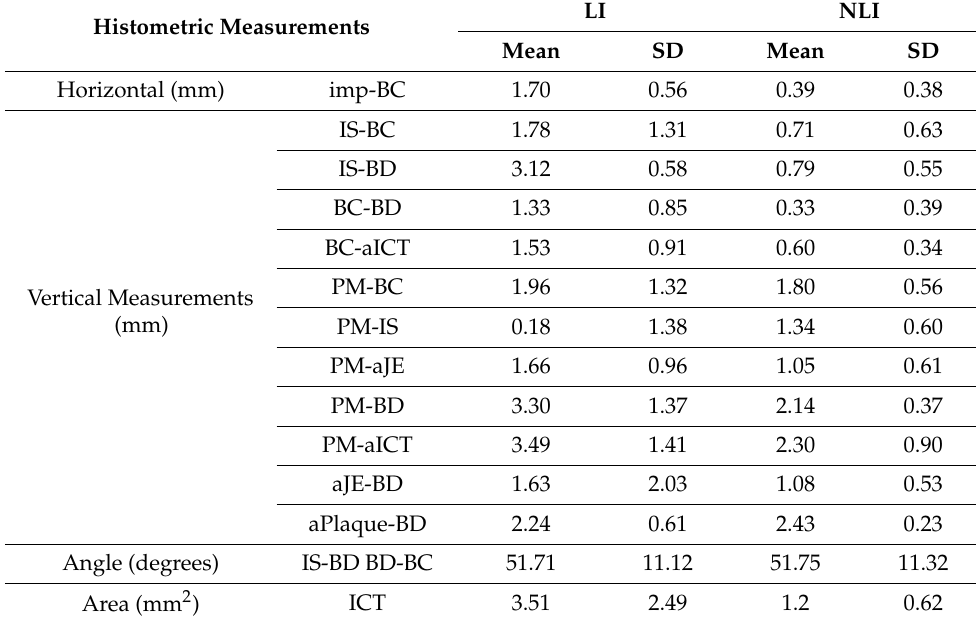
Table 1. Histomorphometric results in LI and in NLI (means and